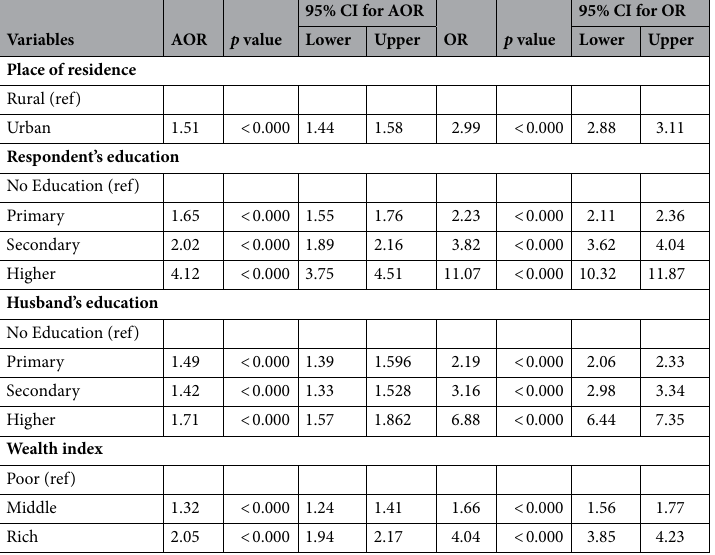
Table 2. Results of the BLR model using pooled data of 36 Sub-Saharan African countries. AOR adjusted odds ratio, CI confidence interval, OR odds ratio; ref reference